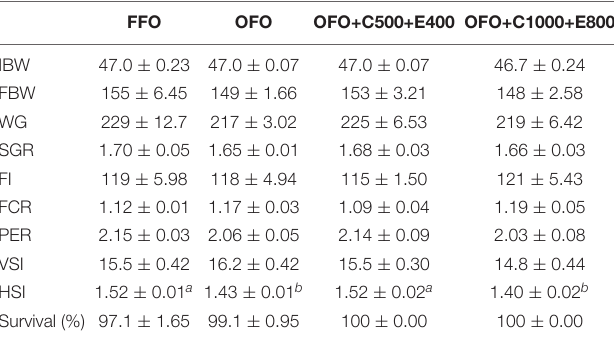
TABLE 2 | Growth, feed utilization, organosomatic indices, and survival rate of rainbow trout ( Oncorhynchus mykiss ) fed the experimental diets for 10 weeks. FFO OFO